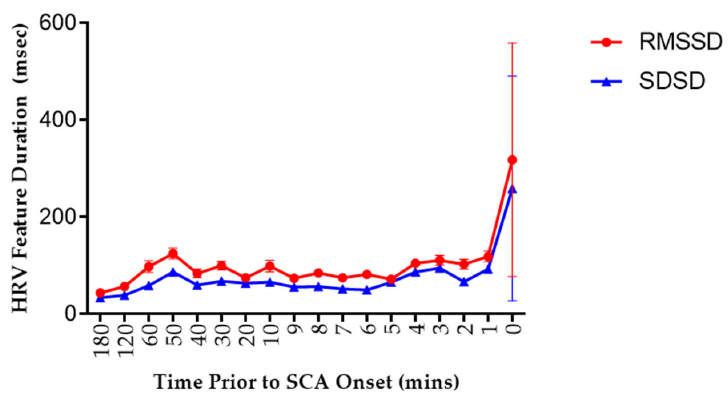
Figure 6. Time series plot of the changes in heart rate variability (HRV): the square root of the mean of differences between all adjacent R ‐ R intervals (RMSSD) and the standard deviation of differences between all adjacent R ‐ R intervals (SDSD) ( n = 10). ECG recordings were taken from patients in the SCA cohort and subjected to processing via MATLAB. The results were recorded as mean RMSSD (±standard deviation) and SDSD (±standard deviation) denoted by the error bars.